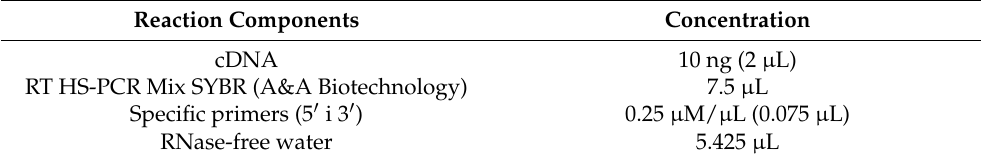
Table 2. List of reaction components used for real-time quantitative polymerase chain reaction (RT-qPCR).